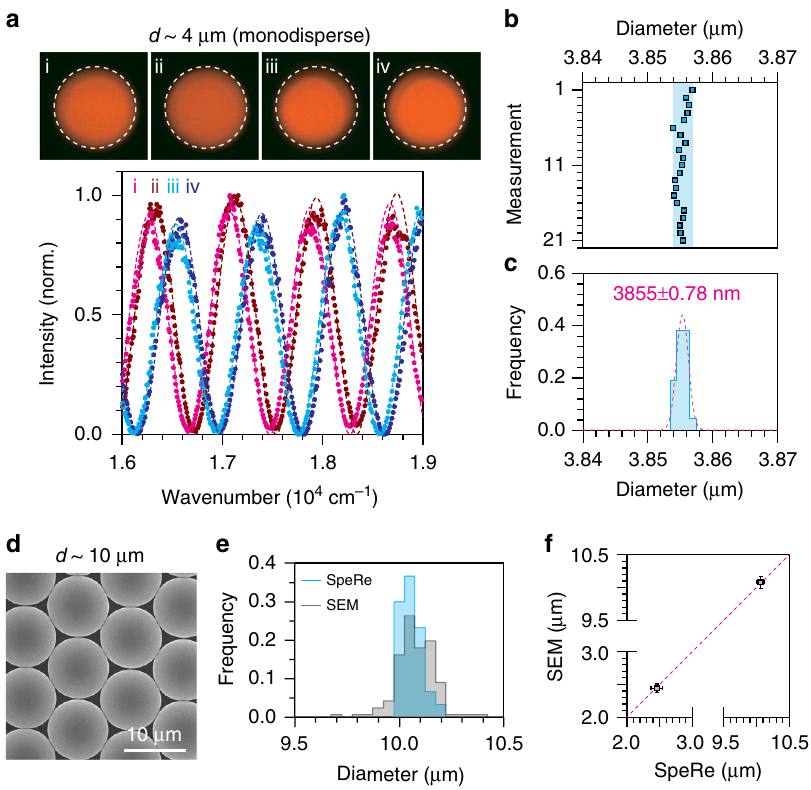
Fig. 2 Proof-of-concept. a SpeRe measurements on polystyrene-based fl uorescent re fl ectophores with a nominal size of 4 μ m. The measured diameters are 3.756 μ m for “ i ” , 3.742 μ m for “ ii ” , 3.693 μ m for “ iii ” , and 3.684 μ m for “ iv ” . Diameters ( d ) were quanti fi ed by fi nding the best- fi t simulated spectrum ( R 2 : 0.99 for “ i ” , 0.98 for “ ii ” , 0.98 for “ iii ” , and 0.98 for “ iv ” ). The upper panel shows fl uorescent images on the corresponding re fl ectophores. b , c Measurement precision. A single silica-based re fl ectophore with a nominal size of 4 μ m was repeatedly measured through SpeRe. Precision in standard deviation was ±0.78 nm ( n = 21 measurements). The shaded blue area in b indicates maximum deviation. The value in c is presented as mean ±